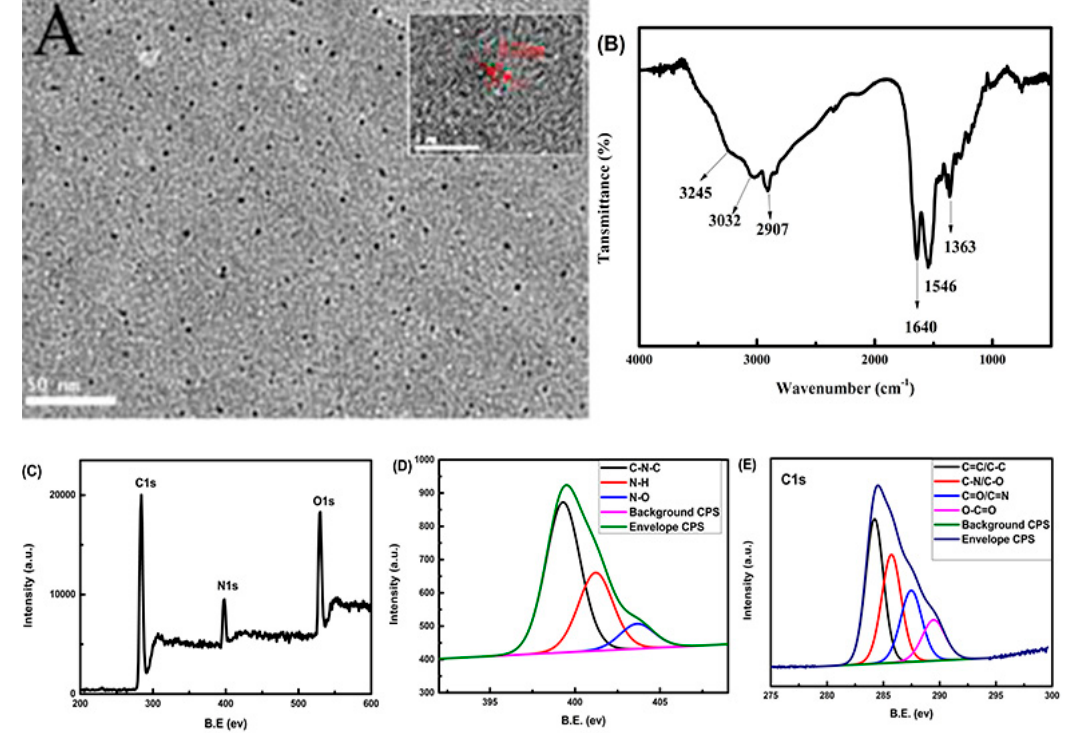
Figure 1. ( A ) TEM image of nitrogen-doped carbon dots (N-CQDs) (insert: local lattice amplification of single N-CQDs); ( B ) the FT-IR spectrum of N-CQDs; ( C ) the full-scale X-ray photoelectron spectroscopy (XPS) spectrum of N-CQDs; ( D ) N1s and ( E ) C1s spectra of N-CQDs.